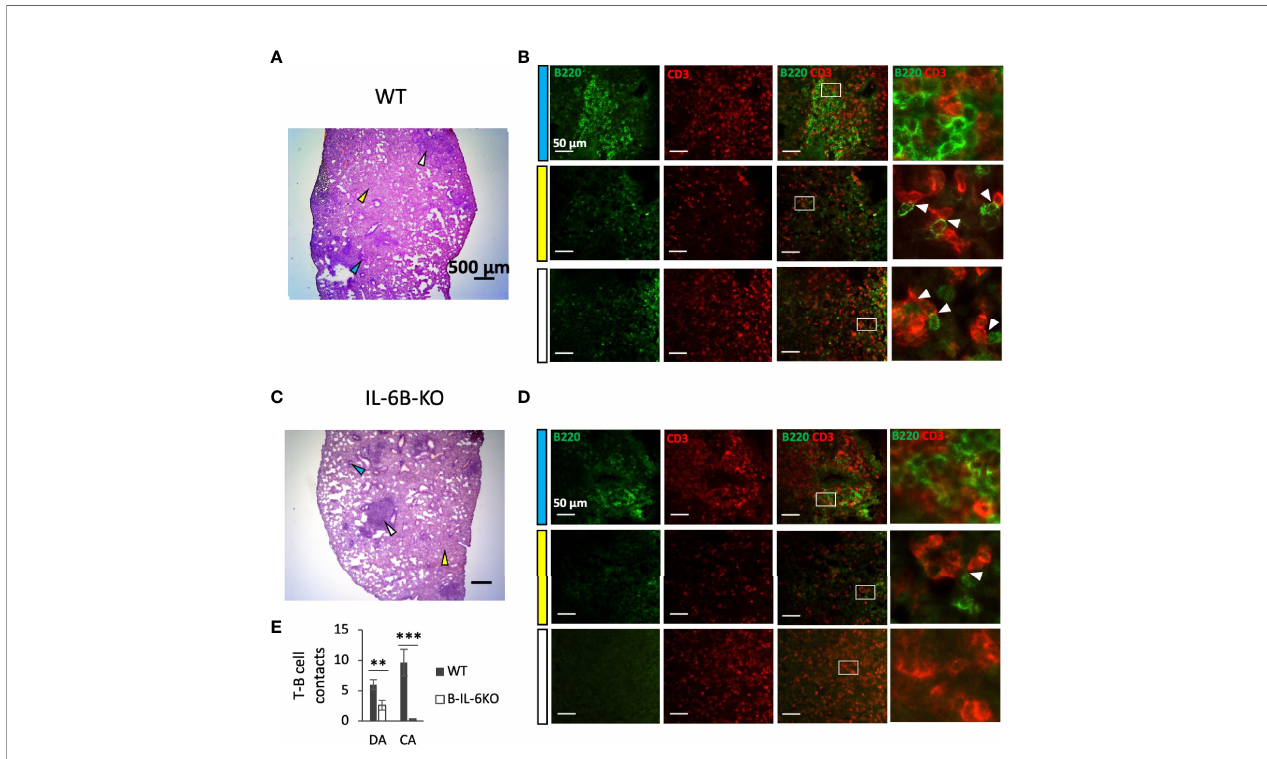
FIGURE 4 | B-cell-speci fi c IL-6 de fi ciency affects early lung pathology and co-localization of T- and B-lymphocytes in areas of diffuse in fl ammation. (A, C) – Representative pictures of lung pathology of WT (A) and B-IL-6KO (C) mice, 3 weeks post challenge. Arrows: blue – lymphocyte cuff near the bronchus; white – condensed in fl ammatory focus; yellow – diffuse in fi ltration. (B, D) – B- and T-cell co-localization within the areas indicated by arrows at (A, C) panels. Blue, white and yellow left-side bars correspond to the colors of the arrows at (A, C) panels. The right panels in (B, D) represent digital magni fi cation of the squared areas, and white arrows point at co-localized B (green- stained) and T (red-stained) lymphocytes. (E) – Quanti fi cation of T-B cell contacts in diffuse (DA) and condensed areas (CA) of lung in fl ammation. Mean ± SD, counted per 10 fi elds. IHC staining of cryosections with a-B220 (for B cells) and a-CD3 (for T cells) antibodies. ** P < 0,01, ***P <